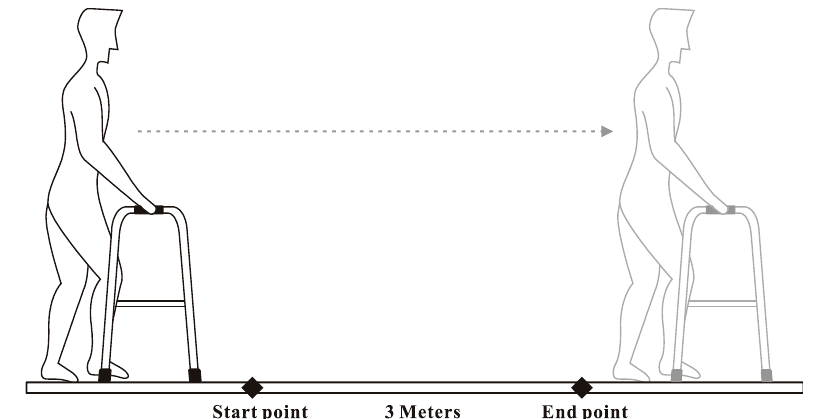
Figure 1. The layout of the experimental setting.